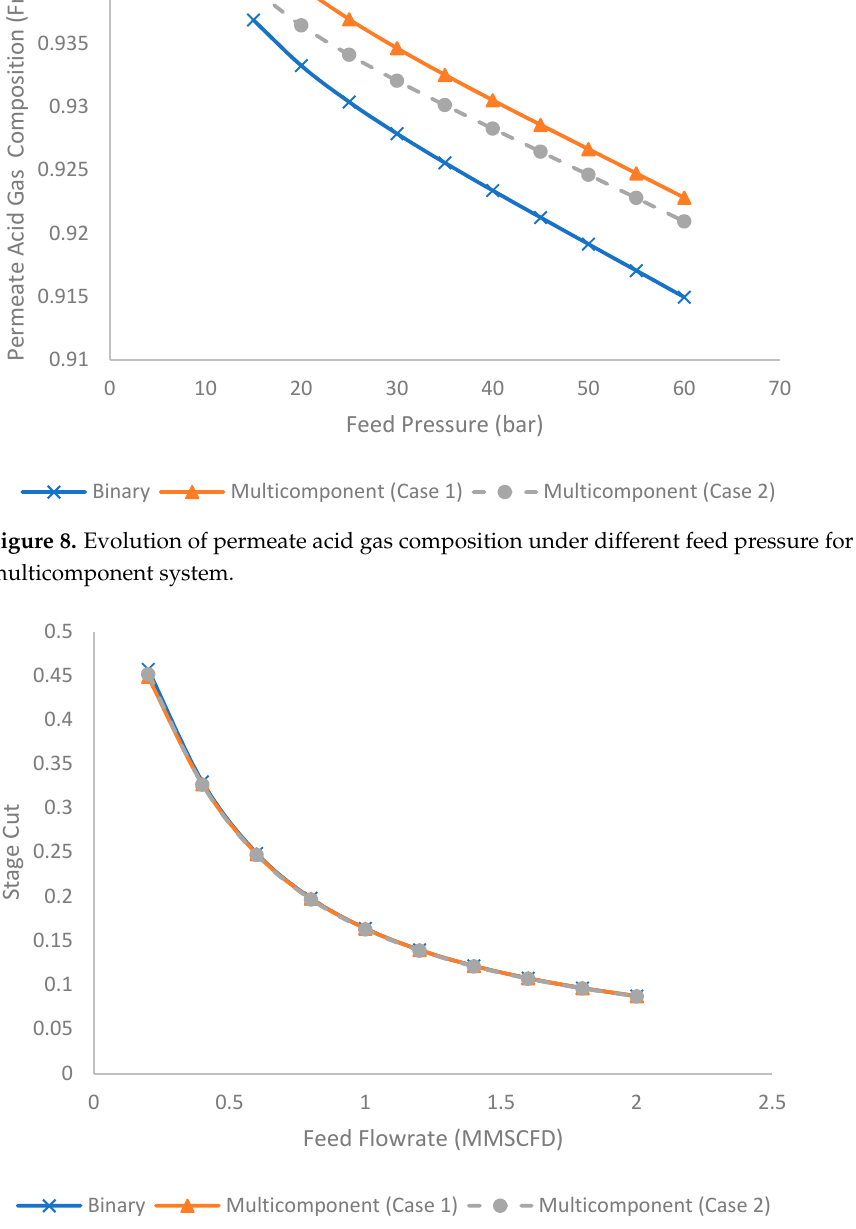
Figure 9. Evolution of stage cut under different feed flow rates for binary and multicomponent